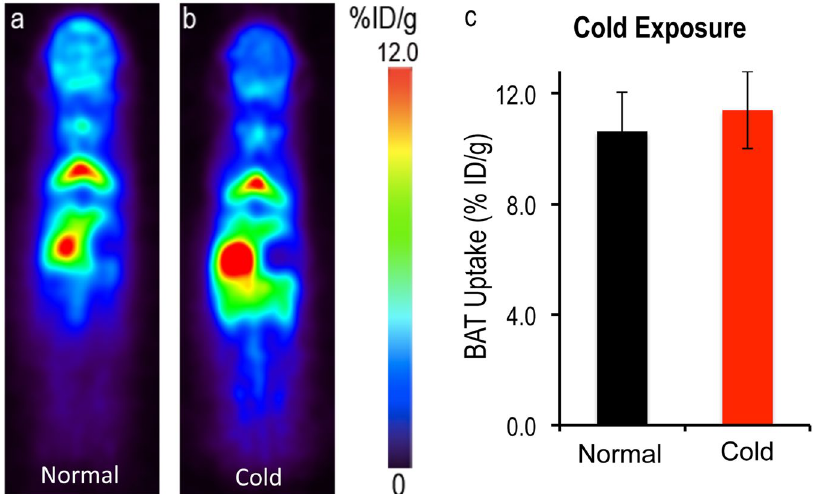
Figure 2. PET images of mice injected 64 Cu-Dis under normal and cold exposure conditions. ( a ) Representative coronal image under a normal condition, ( b ) Representative coronal image under a cold exposure condition, and ( c ) Quantitative analysis of ( a ) and ( b ). There was no significant difference in uptake between control and cold treated groups (p = 0.359).